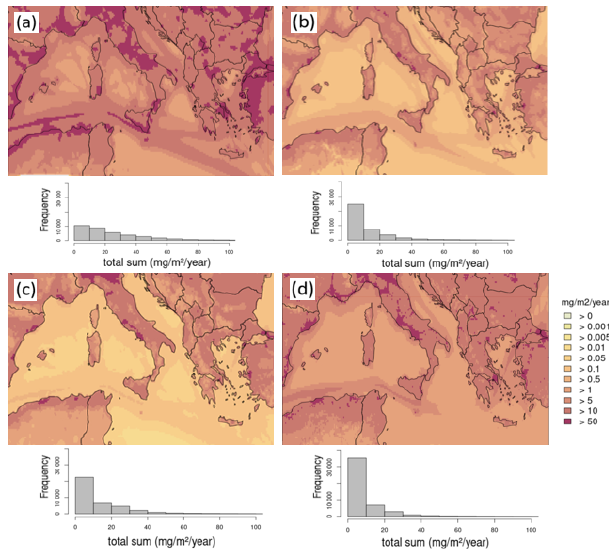
Figure F1. Annual total dry deposition of N. (a) CAMx; (b) CHIMERE; (c) CMAQ; (d)